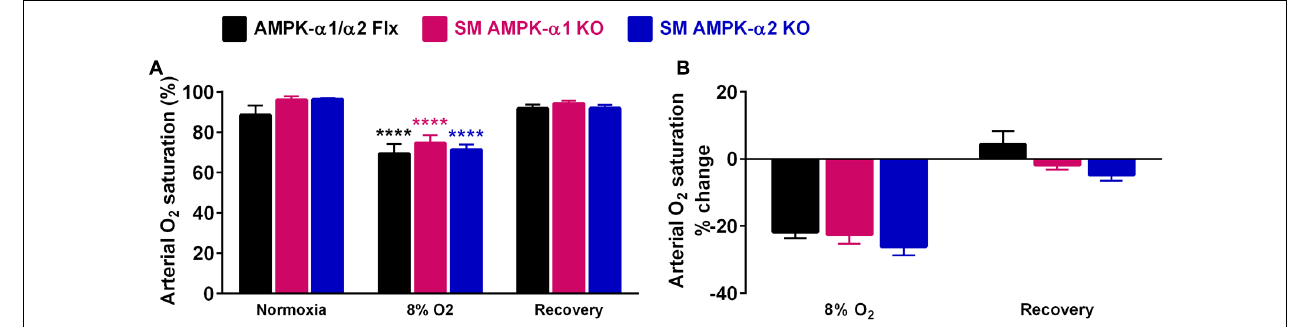
FIGURE 4 | Comparable falls in arterial oxygen saturation were evoked in all genotypes during hypoxia. (A) Bar charts show mean ± SEM for the arterial oxygen saturation ( Sp O 2 ) during normoxia, after 10 min of hypoxia (8% O 2 ) and following recovery to normoxia. (B) Percentage change in Sp O 2 . AMPK- α 1/ α 2 floxed (Flx; black, n = 3), smooth muscle AMPK- α 1 KO (magenta, n = 4) and smooth muscle AMPK- α 2 KO (blue, n = 4) mice; ∗∗∗∗ p < 0.001.